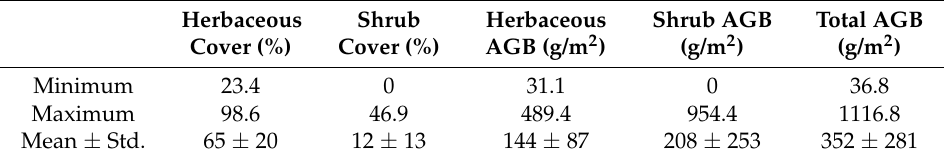
Table 1. Statistics of vegetation cover and biomass from the field sites, n = 46 (1-ha plots). Herbaceous Shrub Herbaceous Shrub AGB Total AGB Cover (%) Cover (%) AGB (g/m 2 ) (g/m 2 ) (g/m 2 ) Minimum 23.4 0 31.1 0 36.8 Maximum 98.6 46.9 489.4 954.4 1116.8 Mean ± Std. 65 ± 20 12 ± 13 144 ± 87 208 ± 253 352 ± 281